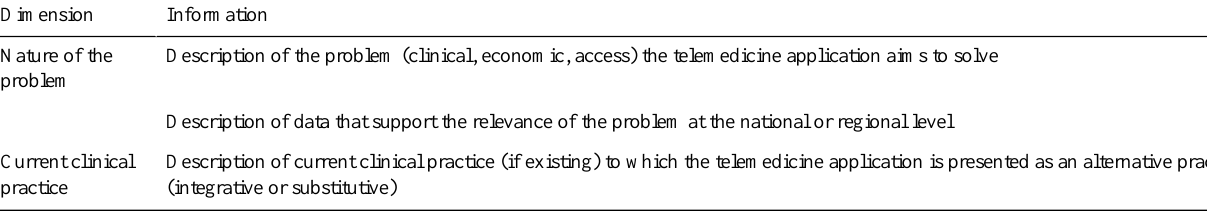
Table 3. Preliminary proposal: description of the context InformationDimension